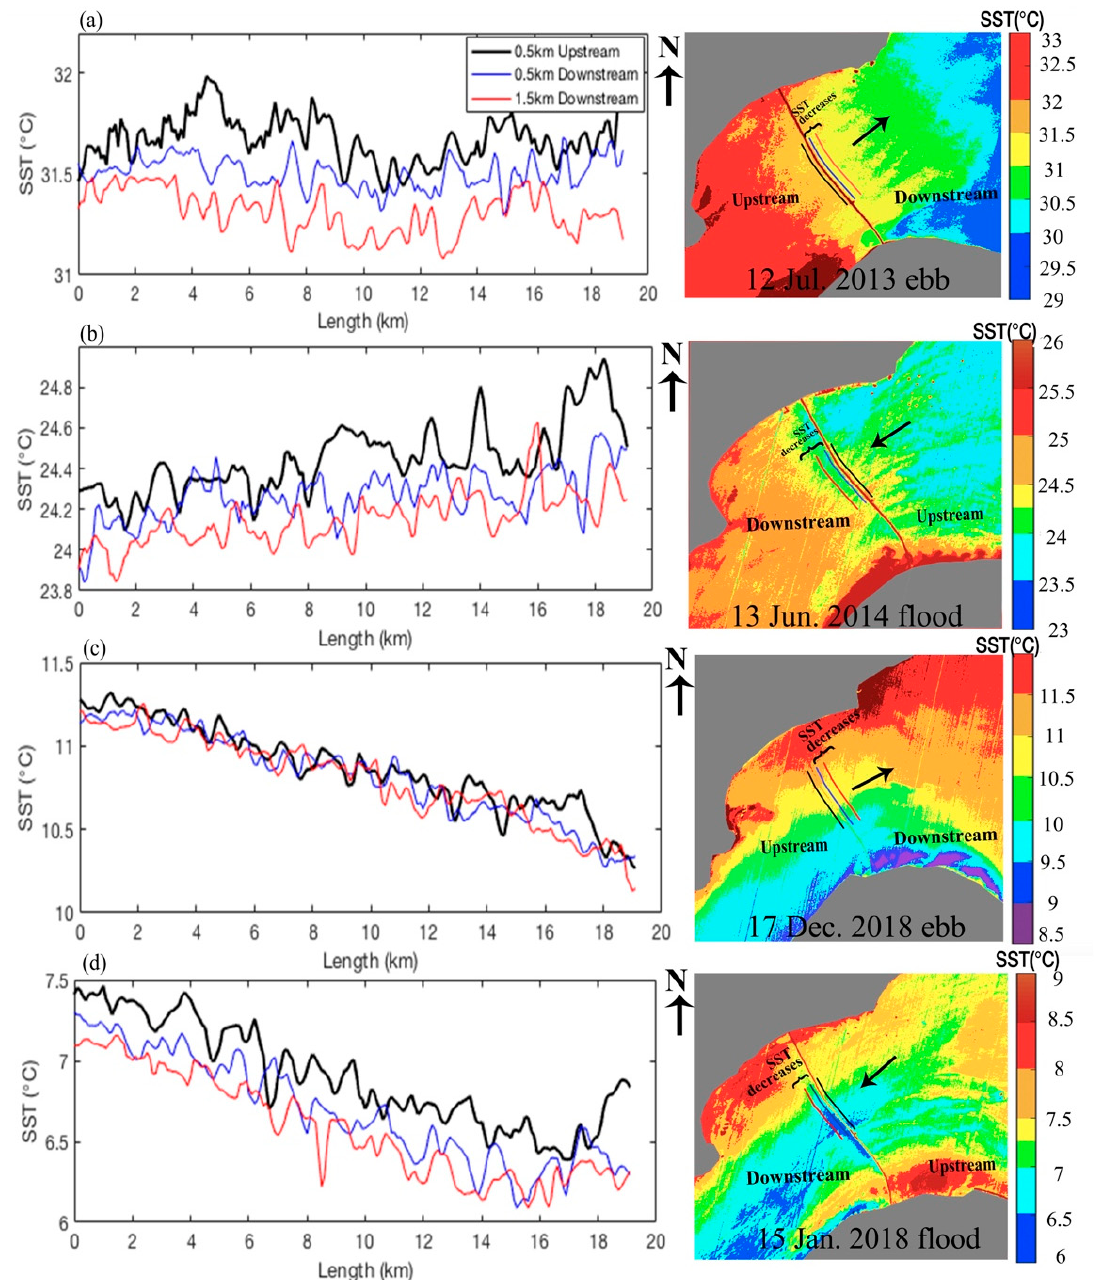
Figure 6. Upstream SST and downstream SST on 12 July 2013 ( a ), 13 June 2014 ( b ), 17 December 2018 ( c ) and 15 January 2018 ( d ). Black line is 0.5 km upstream of the bridge, blue line is 0.5 km downstream, and red line is 1.5 km